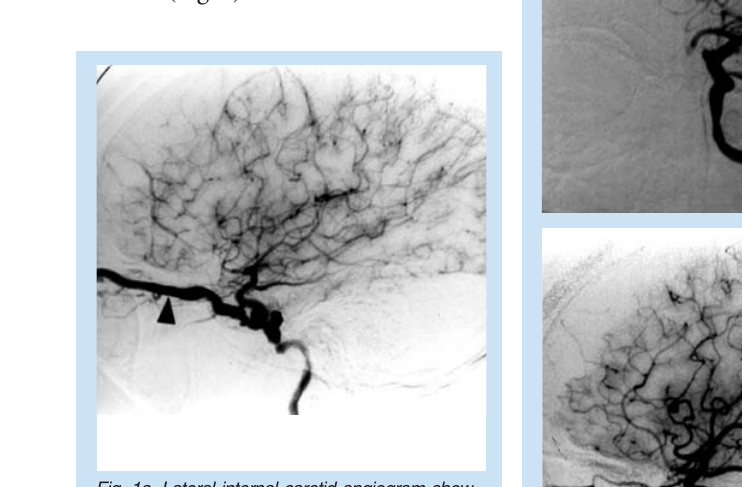
Fig. 1a. Lateral internal carotid angiogram show- ing fistula with preferential venous drainage via dilated superior ophthalmic vein (arrow).